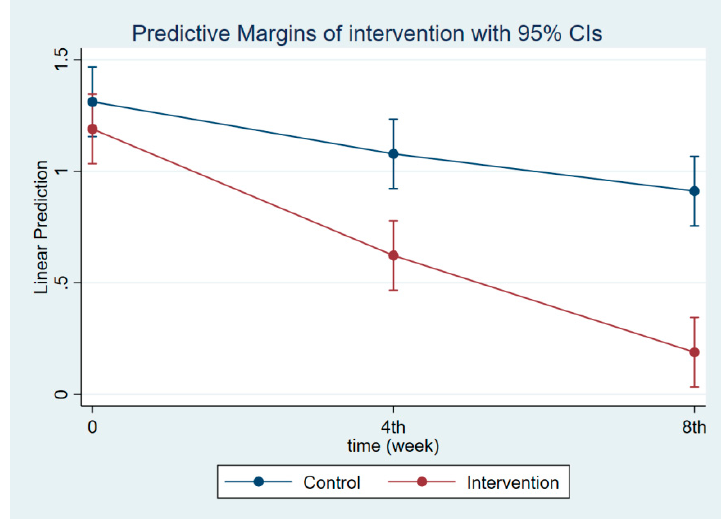
Figure 10. Children’s development scores at follow-ups 1 and 2.